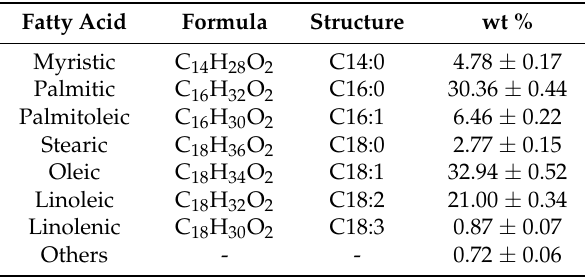
Table 1. Fatty Acid composition of Waste cooking oil (wt %).